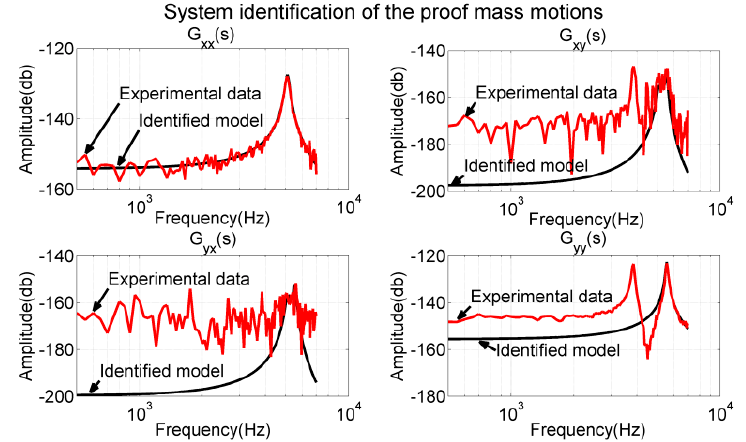
Figure 16. System identification for models G xx ( s ) − G yy ( s ) . The identified models matched well